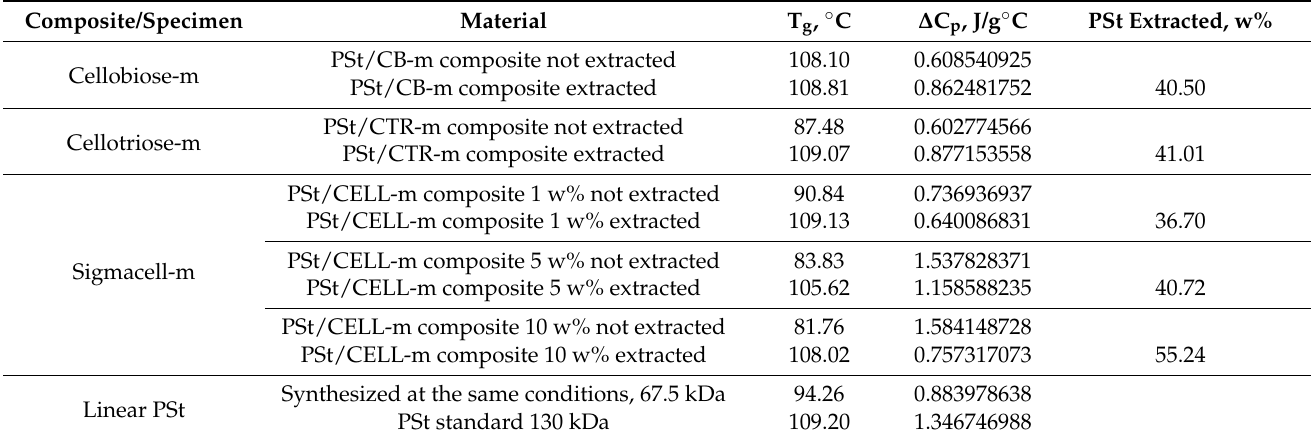
Table 5. Glass transition temperatures (Tg) and heat capacity jump ( ∆ Cp) for samples obtained from DSC. “PSt extracted” shows how much weight % of non-crosslinked PSt was extracted from the sample during the extraction